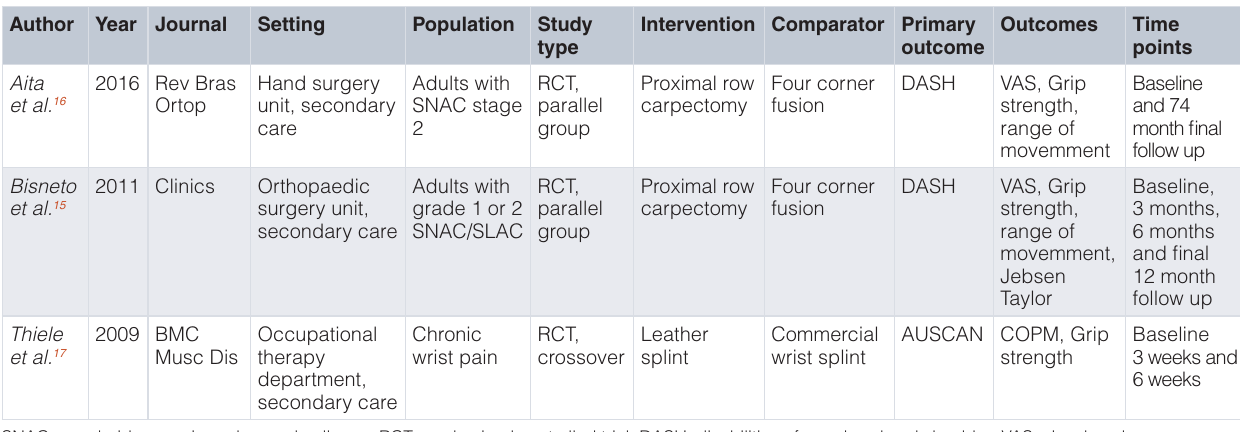
Table 1. Study characteristics.